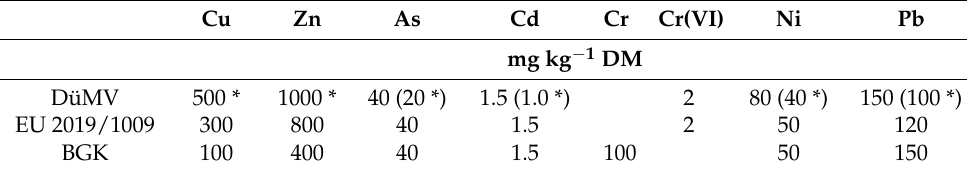
Table A1. Limit values for heavy metals and trace nutrients according to the German Fertilizer Ordinance ( Düngemittelverordnung, DüMV ) [116] and EU 2019/1009 regulation [12]; quality